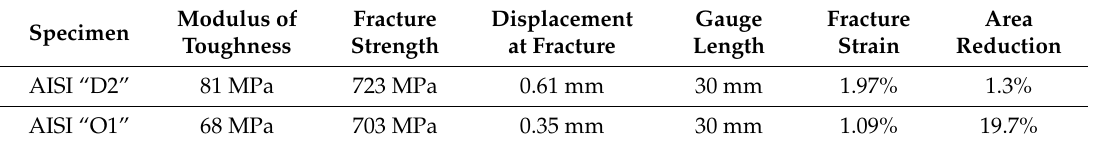
Figure 4. Compression engineering stress–strain curves for “D2” and “O1” tool steels.